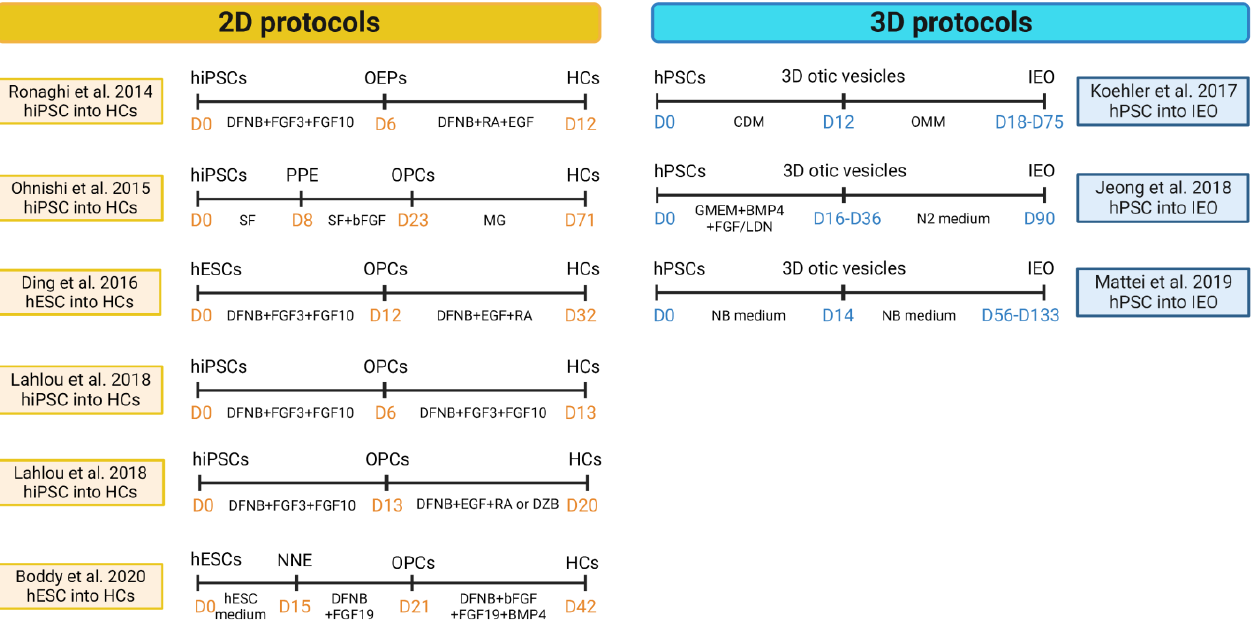
Figure 2. 2D and 3D hPSCs-derived inner ear hair cells protocols [12 – 15,17,18,101,104]. (Created with BioRender.com, accessed on 22 March 2023).